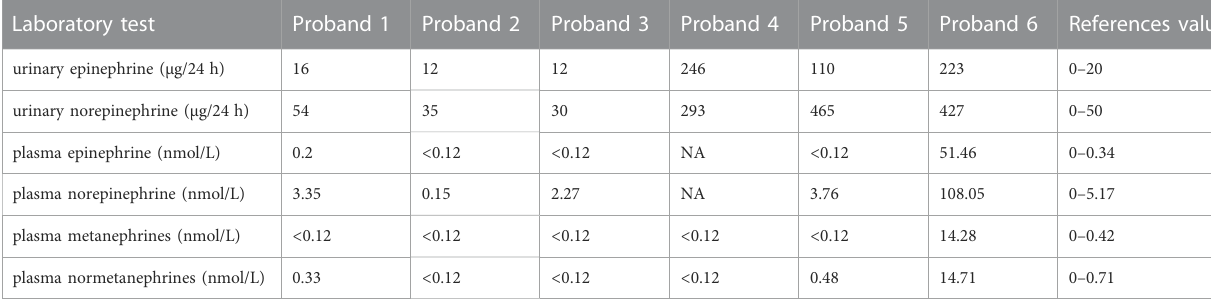
TABLE 1 Concentrations of catecholamines in the six patients.